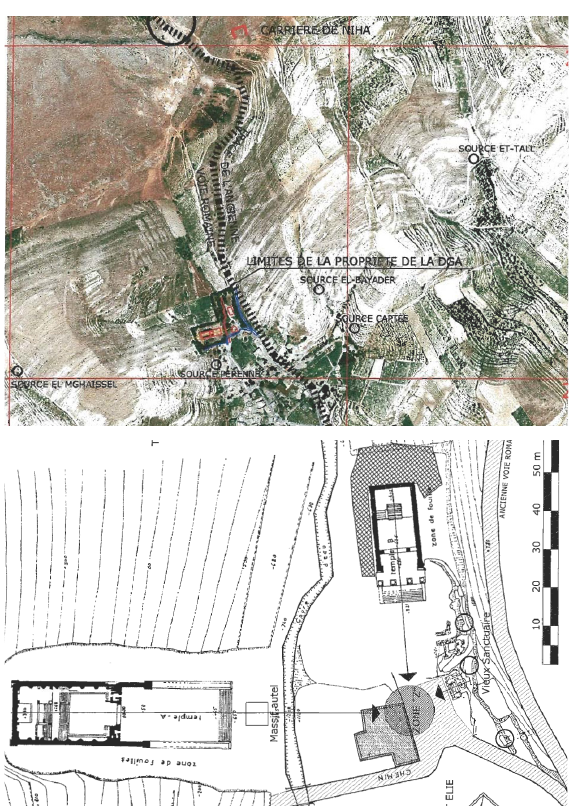
Figure 6. The site of Niha and its various